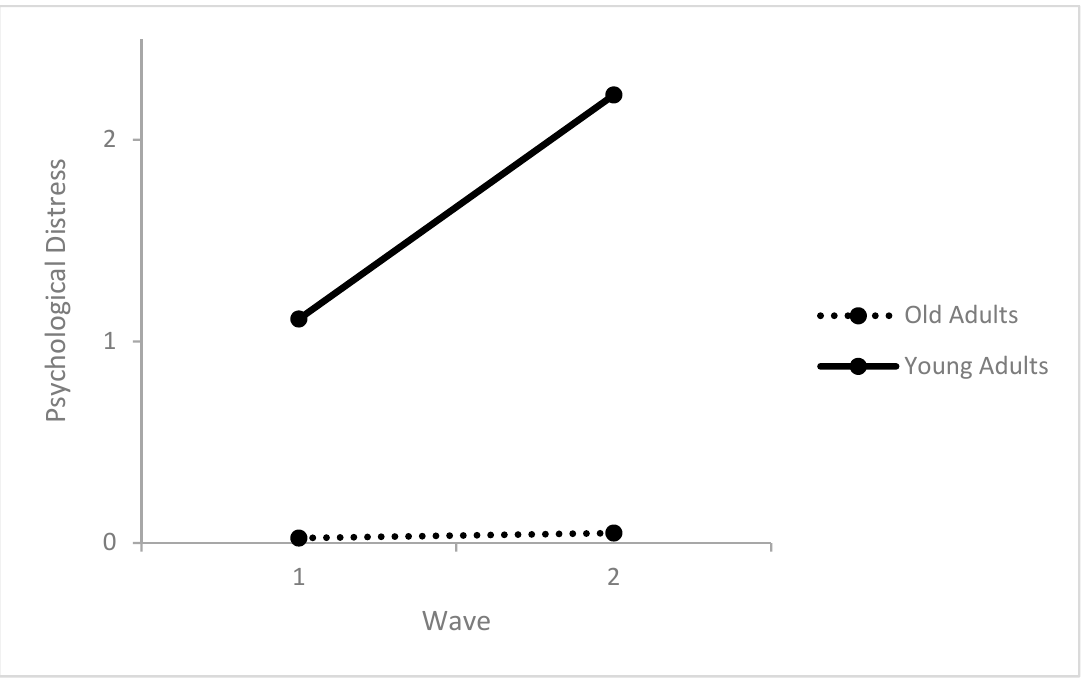
Figure 2. Interactions between the number of surveys and age predicting psychological distress. The views on public institutions’ communication and activities became more negative from survey 1 to survey 2 and were predicted by age and sex. Being women and older adults predicted a more positive view of the public institutions. Finally, when it comes to the change between survey 1 and survey 2 (Table 3), the decrease in positive views of